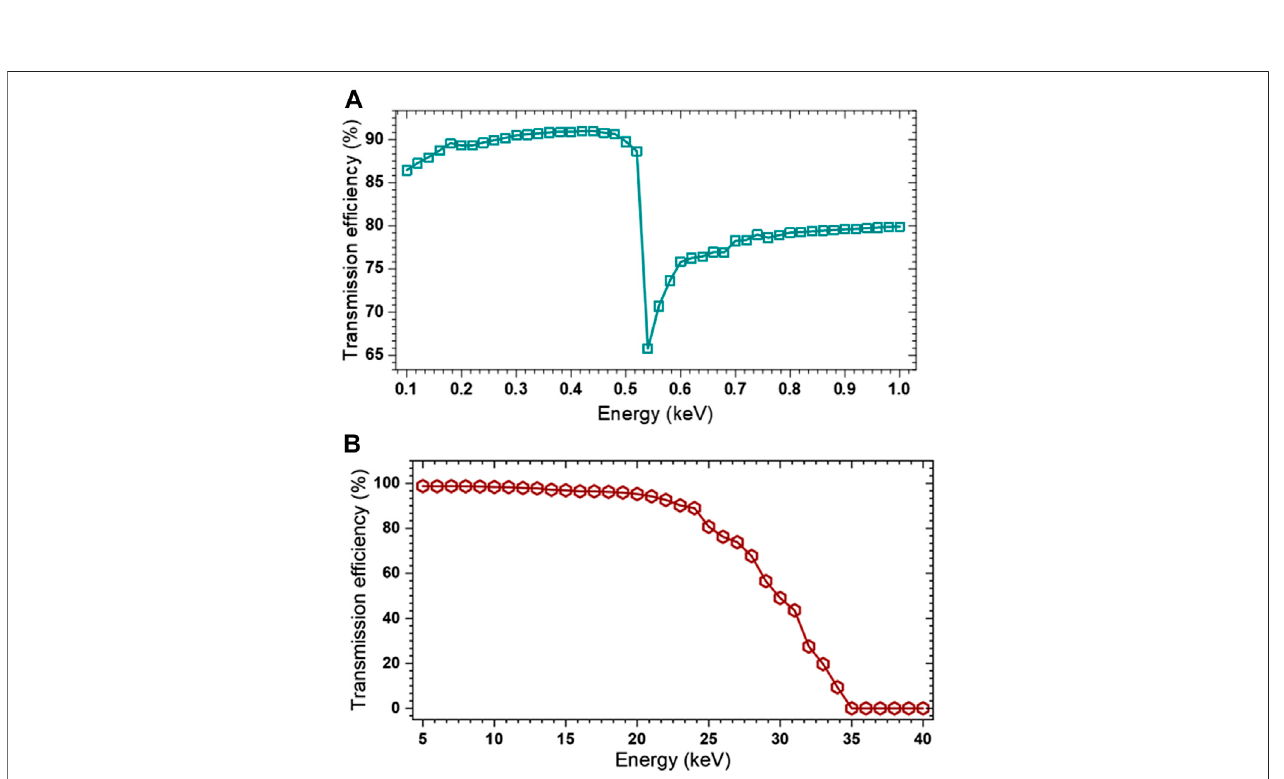
FIGURE9| Energy dependenceofthetransmissionef fi ciency. (A) and (B) are thetransmissionef fi ciencycurvesofthe ellipsoid capillary El 1 and paraboliccapillary Pa 1 , respectively.